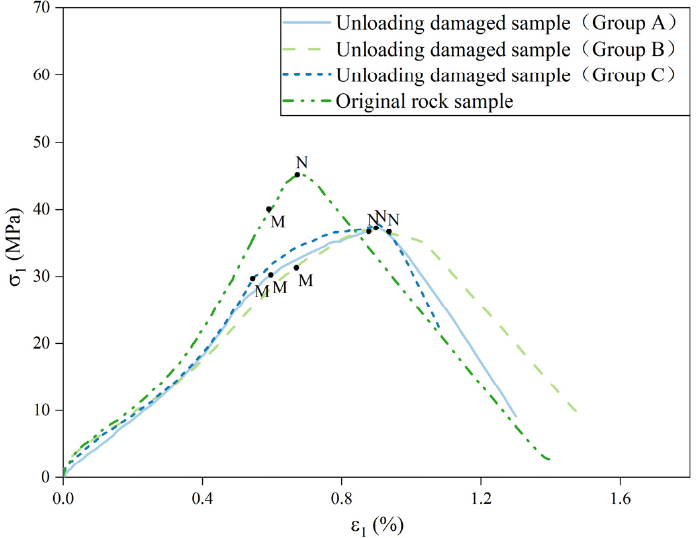
Figure 8. Uniaxially loaded stress-strain curves of unloaded-damaged samples and original samples.